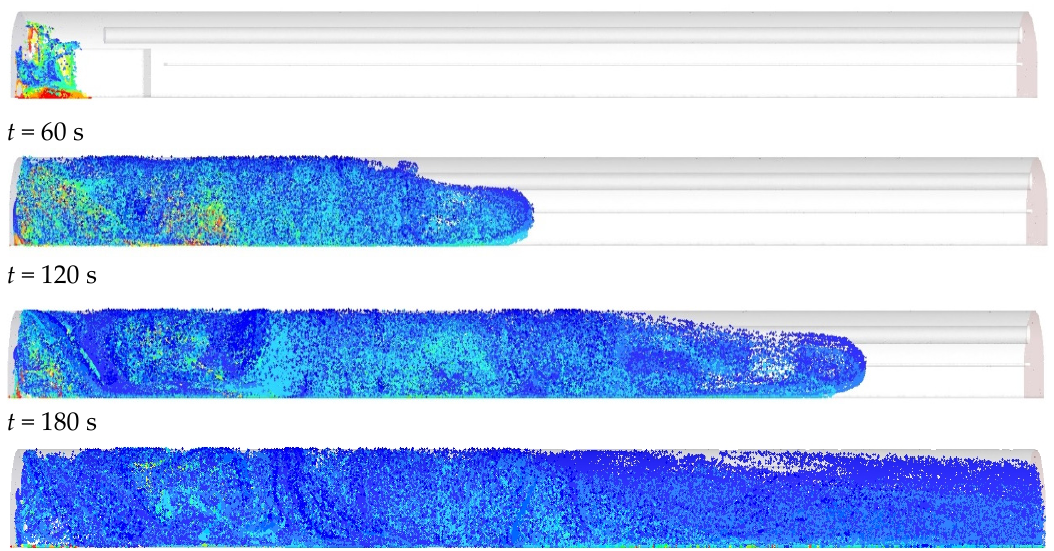
Figure 5. Distribution of different-sized dust particles in the dog heading at various time points for total dust rate = 0.00125